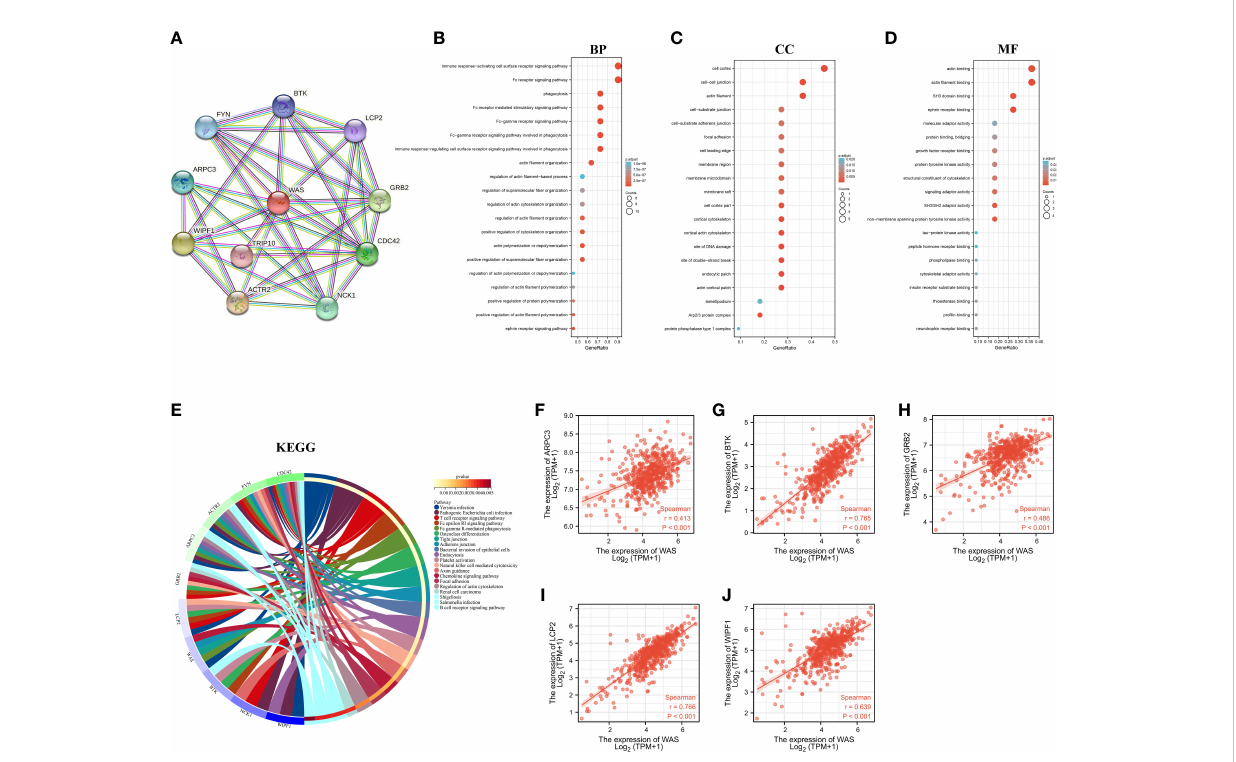
FIGURE 5 PPI network and functional enrichment analysis. (A) WAS and its co-expressed gene network. BP (B) , CC (C) , MF (D) , KEGG (E) enrichment analysis of 10 related genes. (F – J) Correlation analysis of WAS expression with co-expressed genes in ccRCC. BP, Biological Process; CC, Celluar Components; MF, Molecular Functtion; KEGG, Kyoto Encylopedia of Genes and Genomes; ccRCC, clear cell renal cell